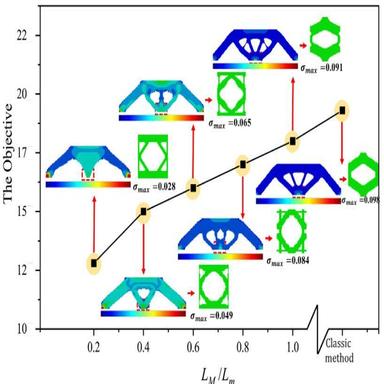
Constraint cases and corresponding results of the optimal design for MBB beam.